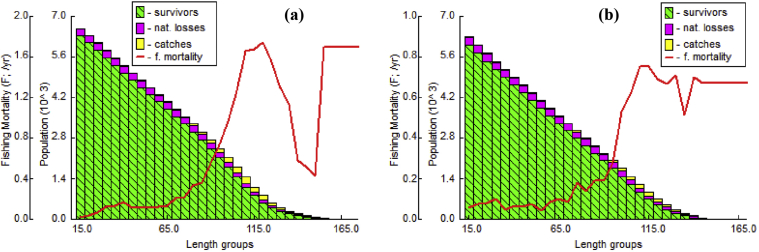
Length (CW) based virtual population analysis for (a) male and (b) female S. olivacea collected from the Sundarban mangrove, Bangladesh.